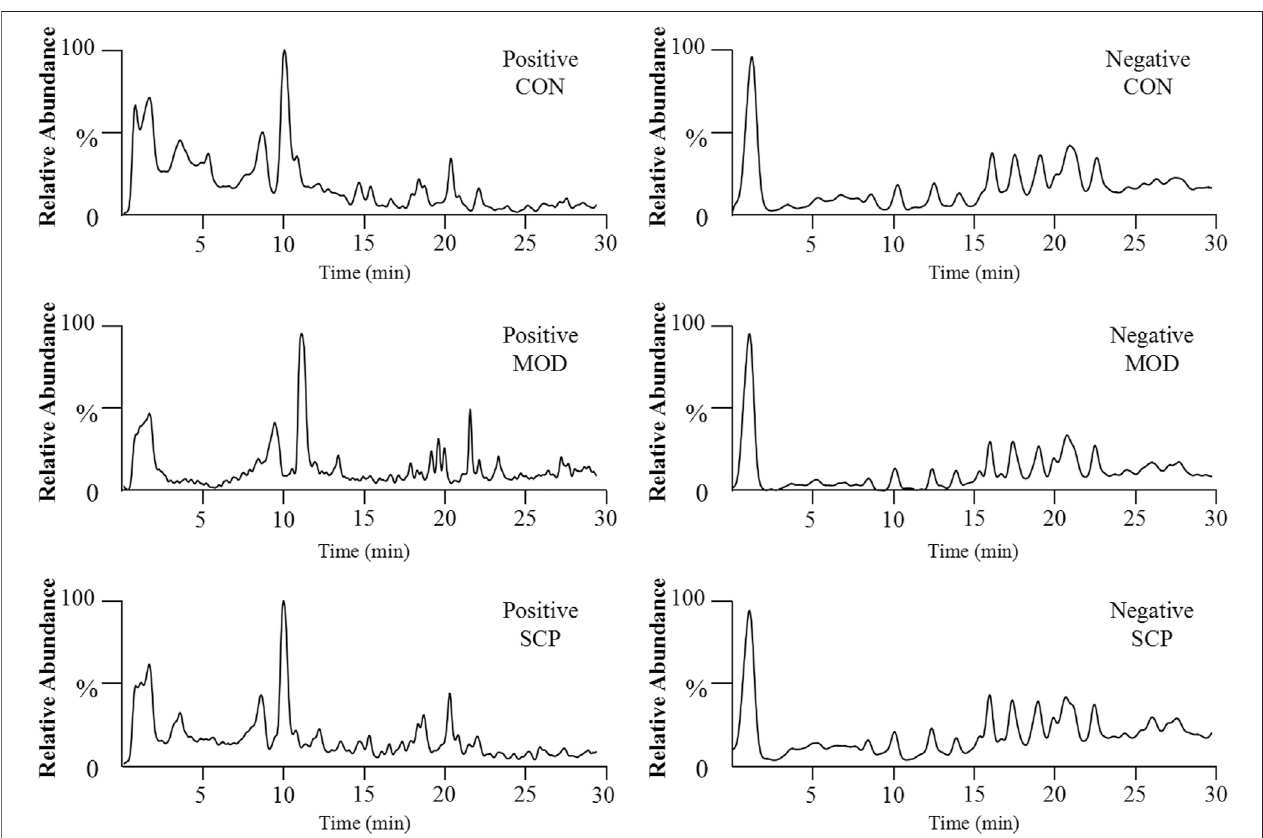
FIGURE 5 | BPI chromatograms of serum samples obtained from the negative and positive ion UHPLC-Q-Orbitrap-MS analyses.